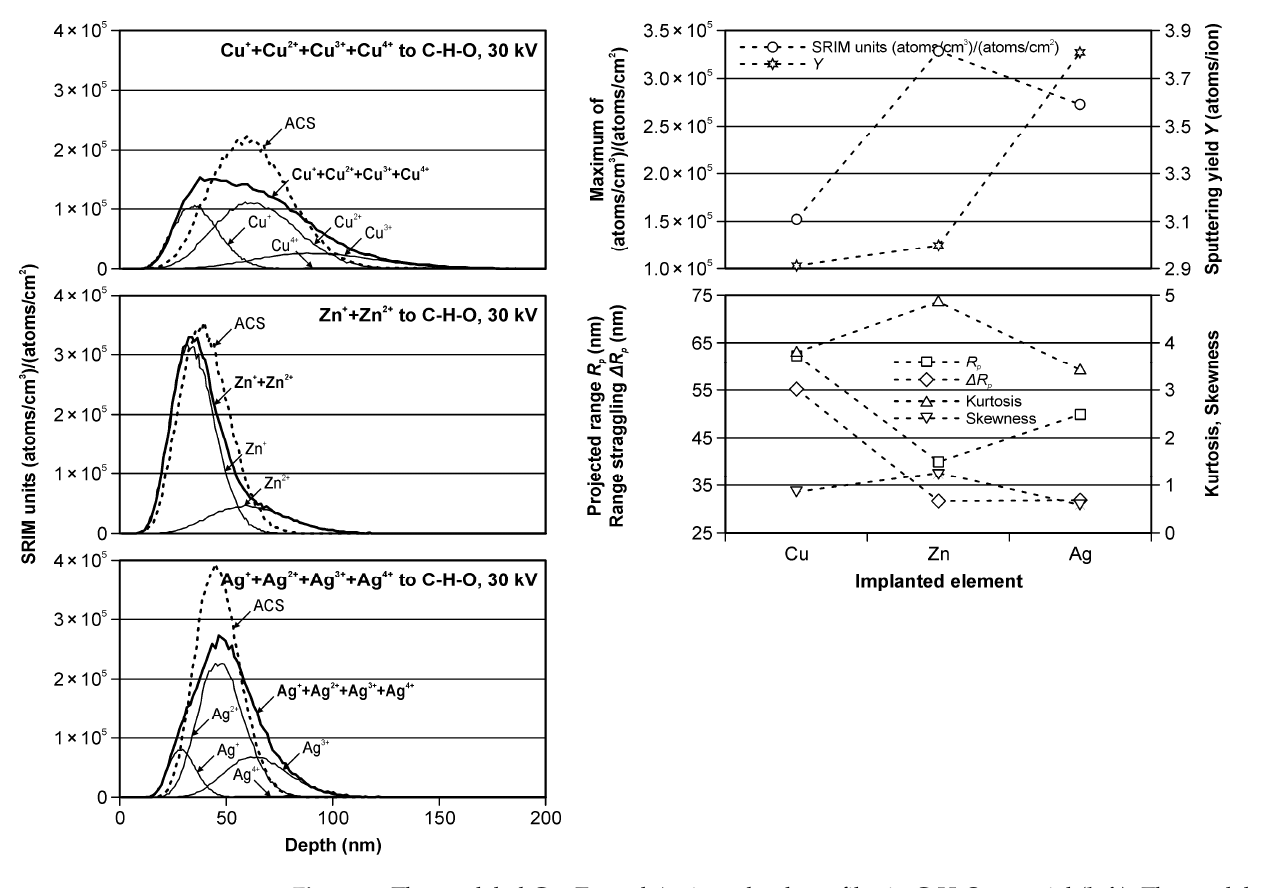
Figure 2. The modeled Cu, Zn and Ag ions depth profiles in C-H-O material ( left ); The modeled values of SRIM units, sputtering yield, projected range, range straggling, kurtosis and skewness as functions of the implanted elements ( right ). Table 2. The peak parameters and sputtering yield values for all implanted cases.